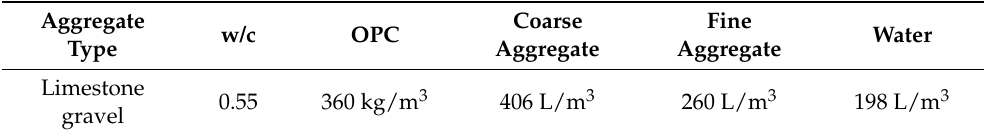
Table 1. Concrete